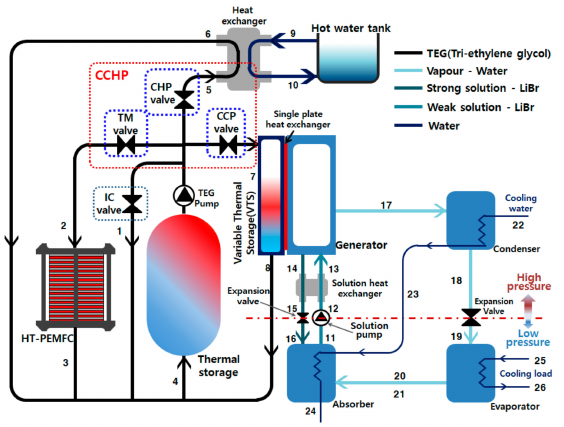
Figure 1. Schematic diagram of the Tri-generative